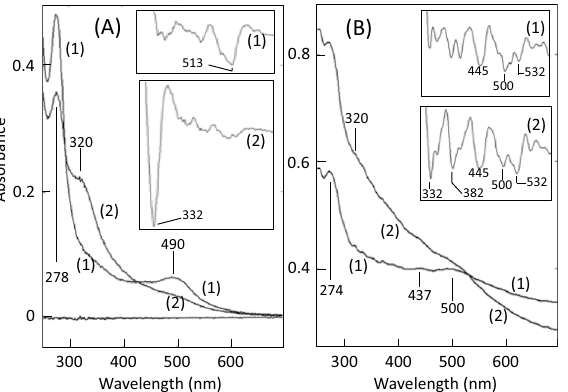
Figure 2. Absorption spectra of the degradation products of proB2 produced by heating and nitrous acid- treatment. Amylose was heated with 0.2 mM proB2 (section "Effects of BSB extract, C3G, and proB2 on starch hydrolysis") and the heated amylose was treated with nitrous acid (section "Effects of nitrous acid-treatment on the hydrolysis of amylose"). The supernatants and the precipitates of amylose were prepared as described in section "Absorption spectra of the degradation products of proB2". ( A ) Supernatants, ( B ) precipitates. Insets, second differential spectra. Δ λ = 20 nm. Traces (1), heated samples; traces (2), heated and nitrous acid-treated samples.